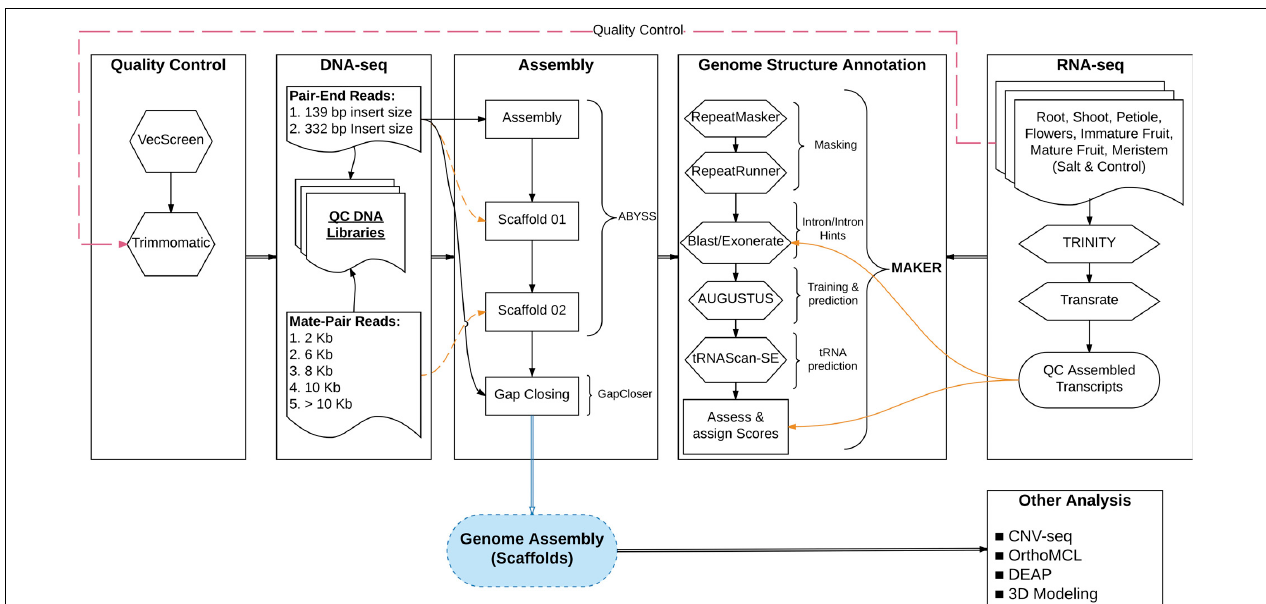
FIGURE 8 | Schematic overview of the main tools used for the genome sequence assembly and annotation of S. pimpinellifolium ’LA0480’. The diagram outlines the workflow and the main tools that were used in the different stages of assembly, gene model annotation and functional